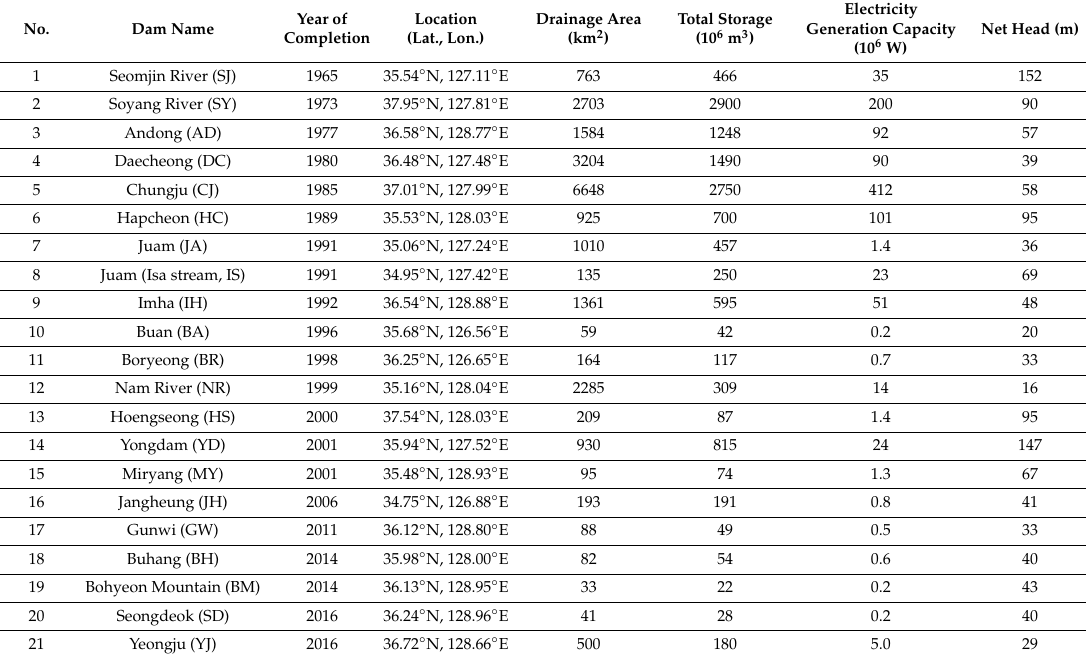
Table 1. Characteristics of 21 multipurpose